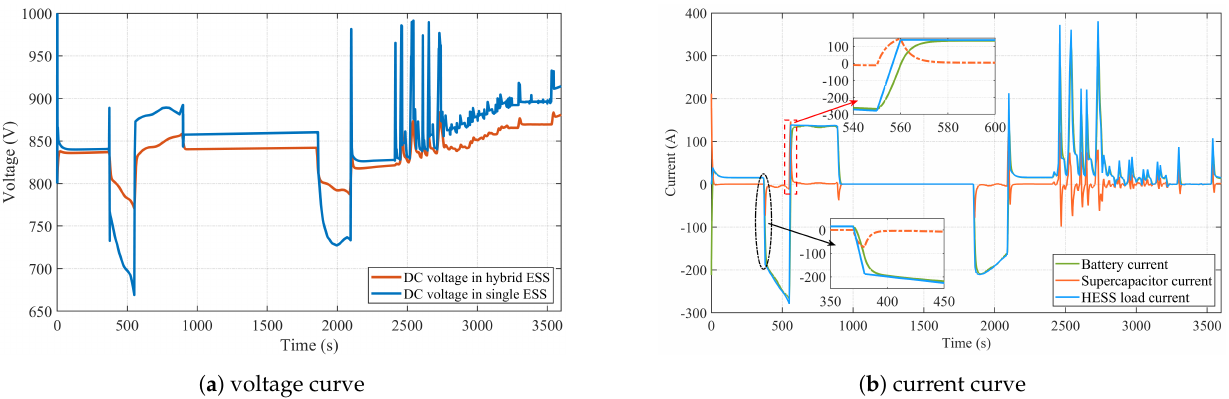
Figure 19. Voltage and current curve of energy storage devices in the single and hybrid